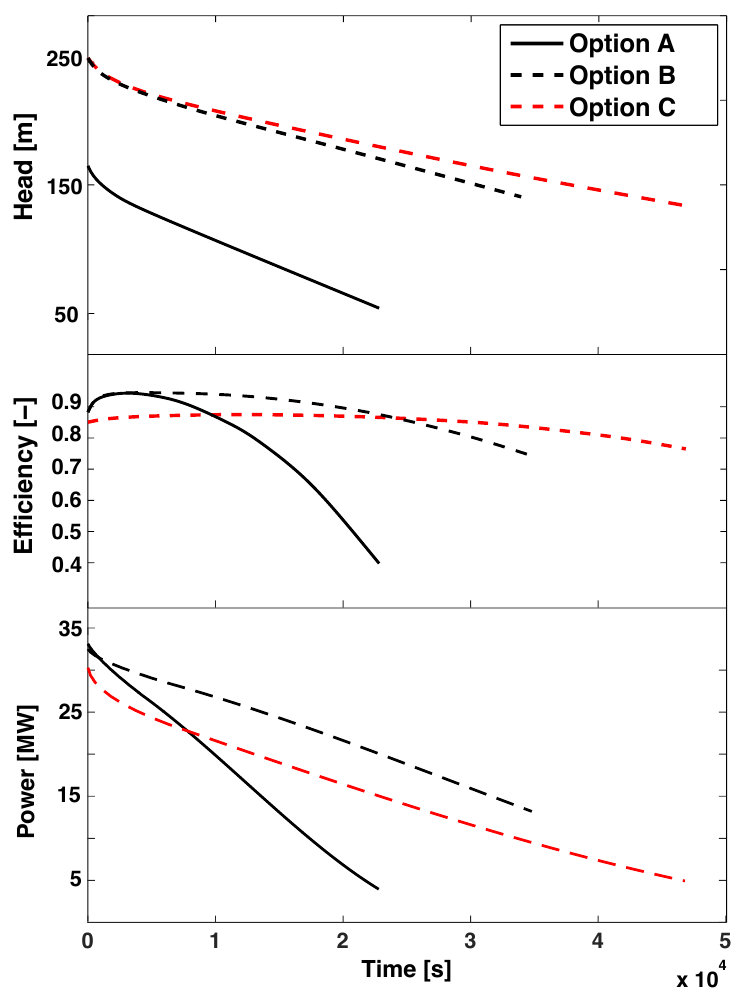
Figure 4. The evolution of the gross head, hydraulic efficiency and power by time for the three turbomachinery configurations A, B and C. Please note in configuration C, pump as turbines (PATs) are coupled with a variable speed